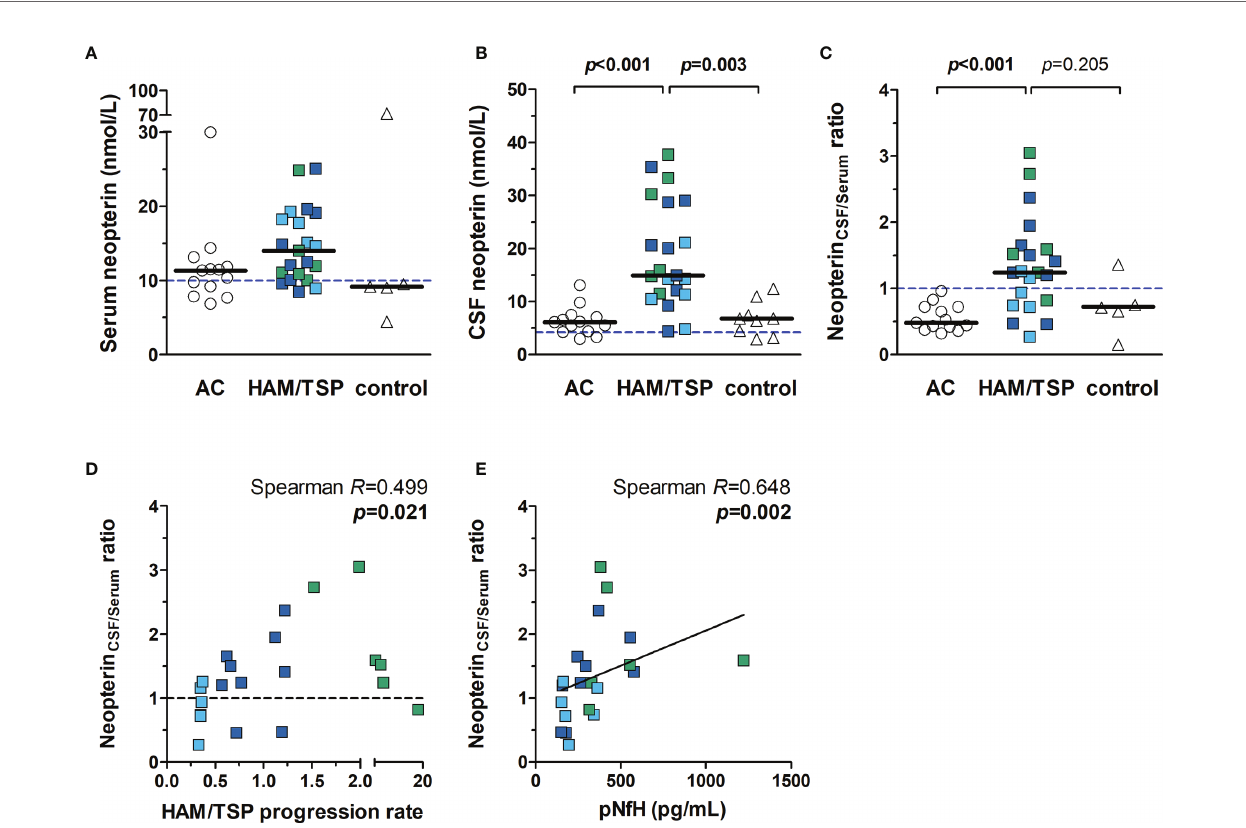
FIGURE 4 | Neopterin concentration in the serum and CSF of HTLV-1-infected individuals. Neopterin was quanti fi ed by ELISA in the (A) serum and (B) CSF of HTLV-1 asymptomatic carriers (AC) (n=13) and HAM/TSP patients (n=21). HAM/TSP patients were identi fi ed according to the speed of disease progression as very slow (light blue), typical/slow (dark blue) and rapid (green). (C) The ratio between CSF and serum neopterin concentration was calculated for each individual, and those with values > 1.0 were considered with active central nervous system in fl ammation. Serum (n=5) and CSF (n=9) samples of HTLV-1 seronegative individuals were included as controls. Statistical analysis was performed with Kruskal-Wallis test with Dunn ’ s post-test for multiple comparisons, and p -value < 0.05 was considered signi fi cant. (D) Spearman ’ s correlation rank was used to evaluate the association between neopterin CSF/Serum ratio and HAM/TSP progression rate (points/year), de fi ned as the quotient between the score in IPEC-2 disability scale and the time of disease in years. (E) Correlation between neopterin CSF/Serum ratio and CSF levels of phosphorylated neuro fi lament heavy chain (pNfH), a biomarker of axonal degeneration. Dashed lines indicate reference values for (A) serum neopterin (< 10 nmol/L), (B) CSF neopterin (< 4.2 nmol/L), and (C, D) neopterin CSF/Serum ratio (<